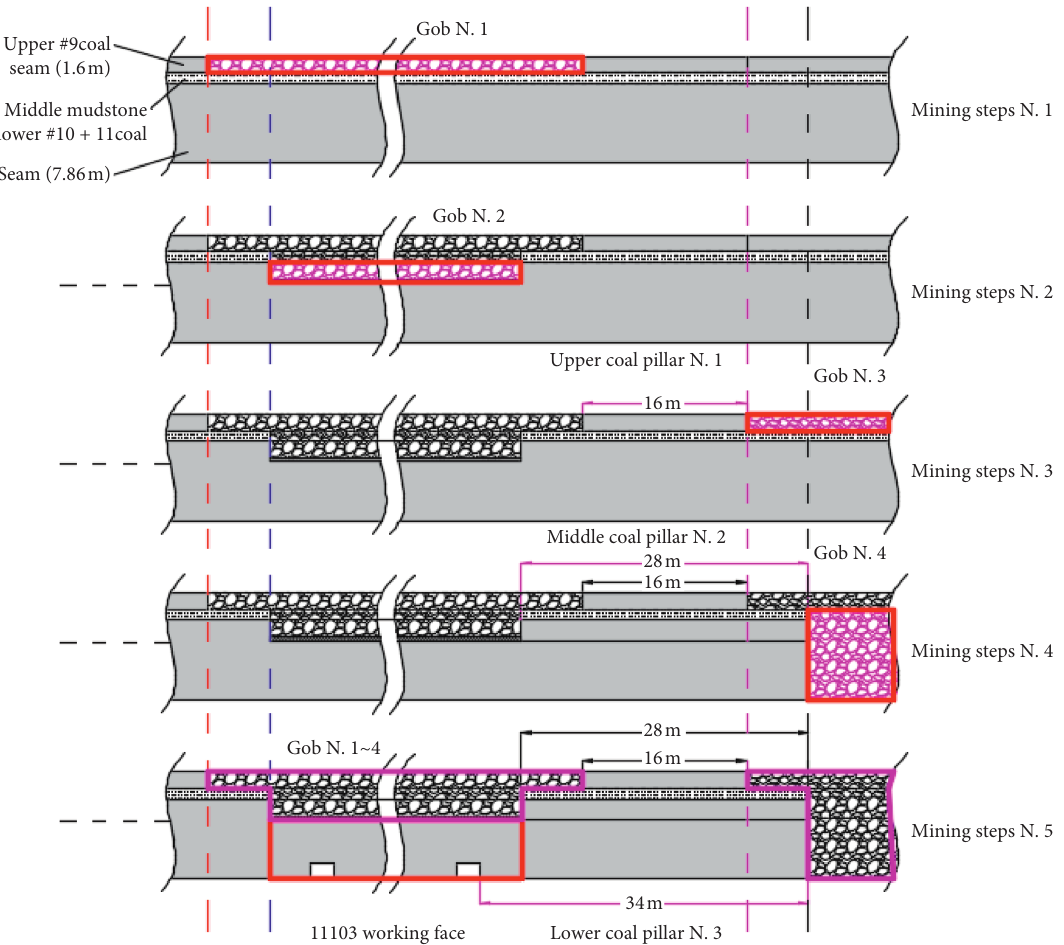
Figure 3: Mining sequence of double gobs in close coal